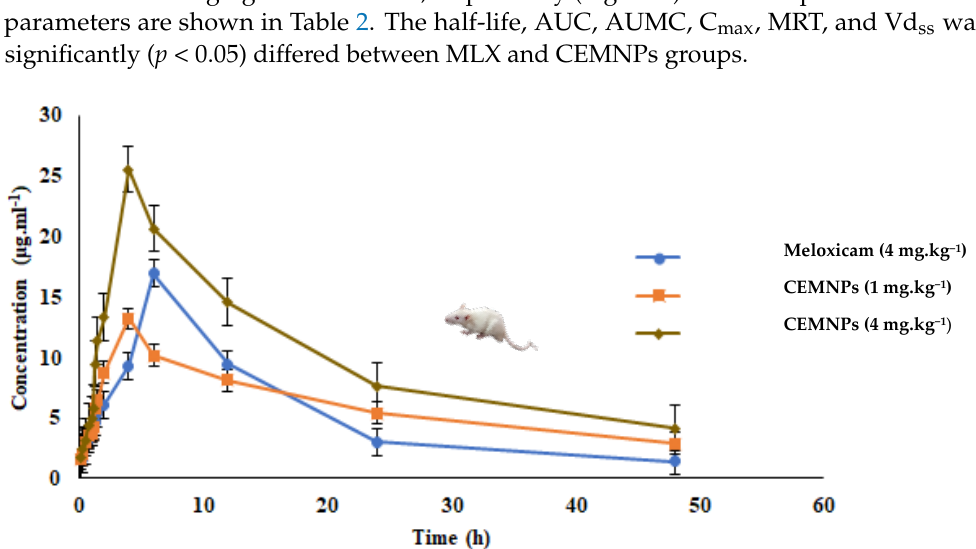
(477.552 ± 7.99 μg·mL *h −1 ), in comparison to MLX (256.569 ± 2.022 μg·mL *h −1 ). Thus, the